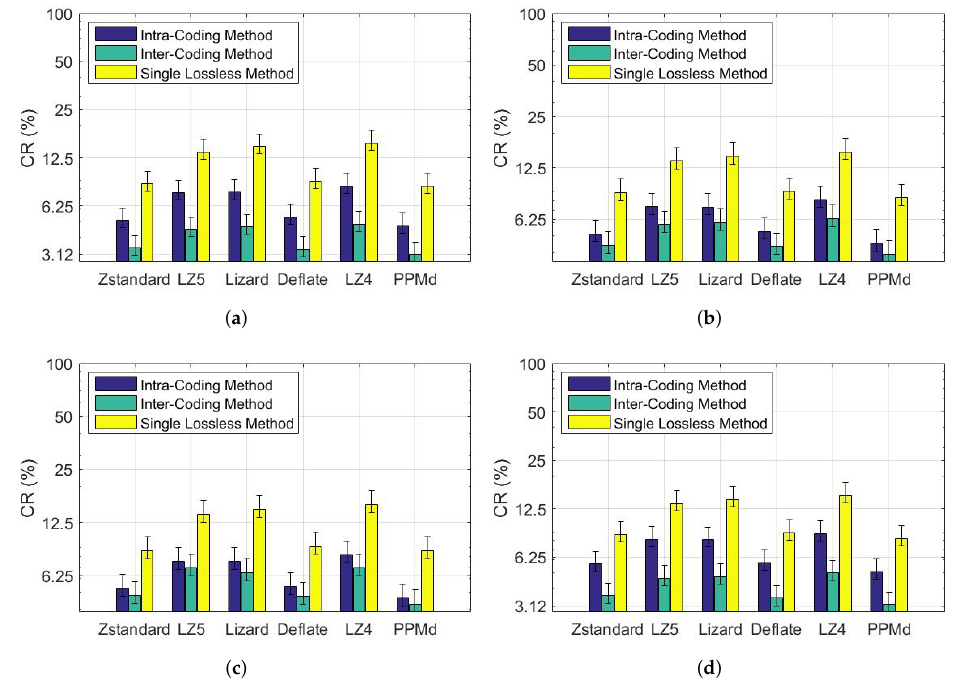
Figure 5. CR of different lossless coding schemes: ( a ) campus; ( b ) city; ( c ) road; ( d ) residential. For intra-coding, the smallest CR value is 4.64%, achieved by using the PPMd scheme for the city scene due to its simple structure. The point cloud of the residential scene, however, is complex and the CR is much higher. The smaller the CR, the better the coding